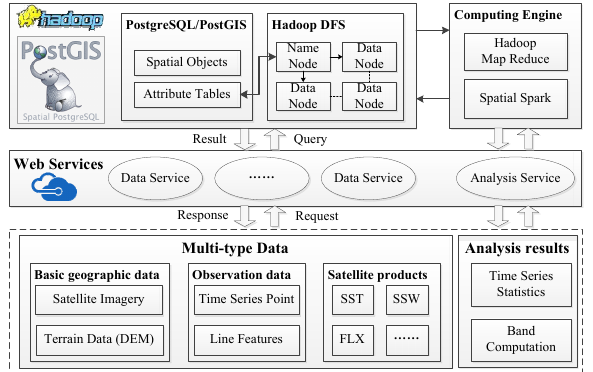
Figure 2. Cloud-based data